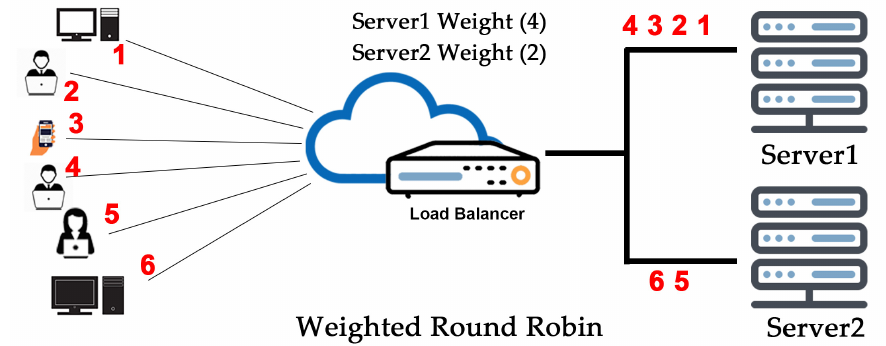
Figure 2. Weighted round robin algorithm.